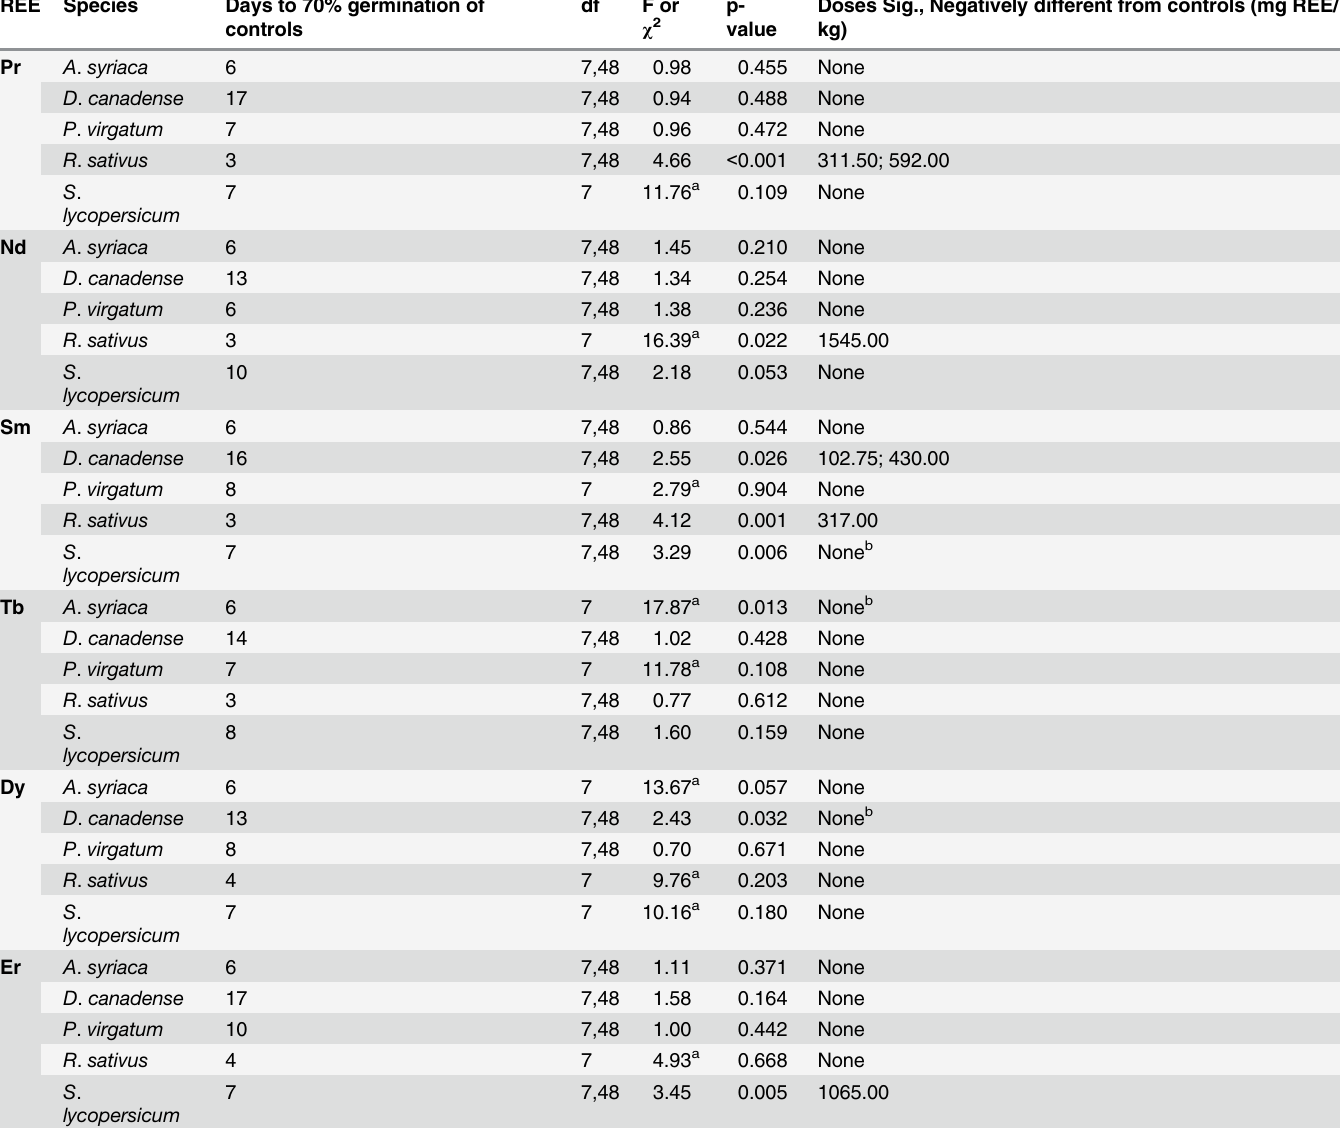
Table 4. Analyses (ANOVA or Kruskal-Wallis test) of the effects of rare earth element (REE) soil dosage on the speed of germination of five plant species. REE Species Days to 70% germination of